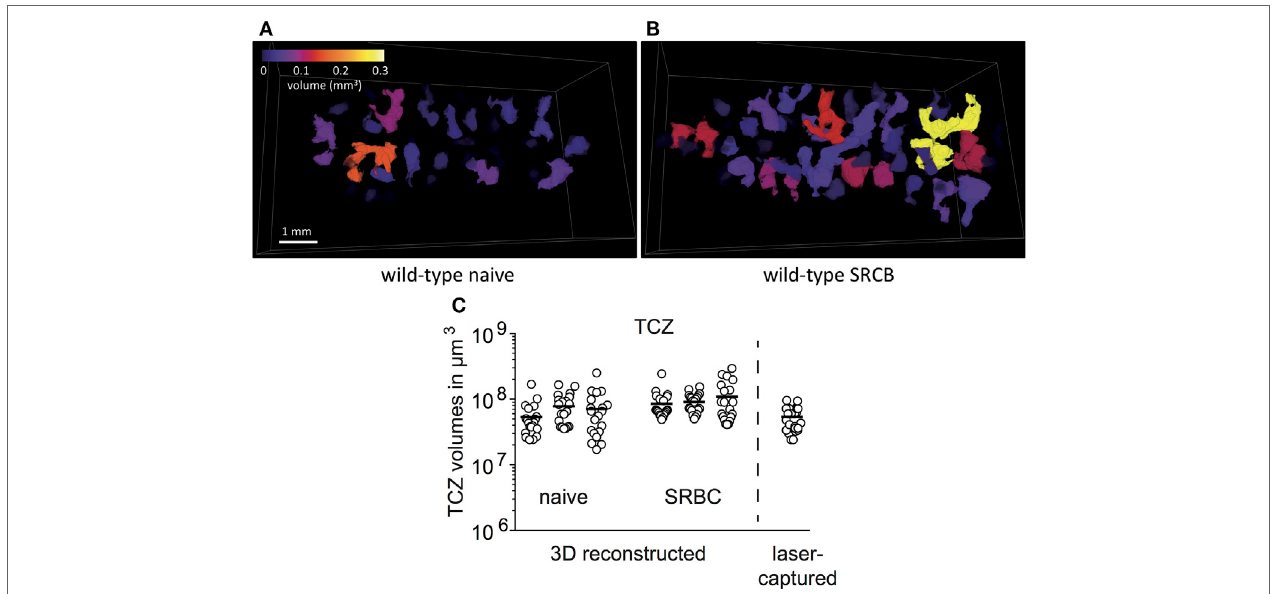
FigUre 2 | Laser-microdissection allows the isolation of entire T-cell zones (TCZ). A complete collection of sections of about half a spleen from wild-type mice was stained for B cells (blue, B220) and T cells (brown, TCR β ), imaged by automatic scanning microscope and 3D reconstructed by For3D software. (a,B) Color-coded individual TCZ from spleens of wild-type mice before (a) and after immunization (B) are shown. Please see Videos in Supplementary Material. (c) 3D reconstructed spleens were used to determine the volumes of the 20 largest TCZ with Matlab ( n = 3, 20 TCZ per spleen). The volumes of three naive and three immunized spleens from wild-type mice are shown and compared to the volumes of TCZ that were harvested by laser-microdissection and estimated from 2D cryo-sections ( n = 12, two TCZ per